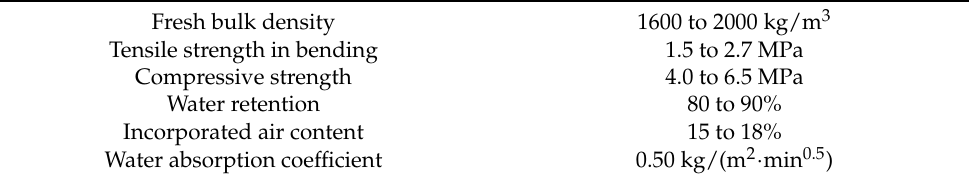
Table 2. Properties of the industrialized mortar used in the